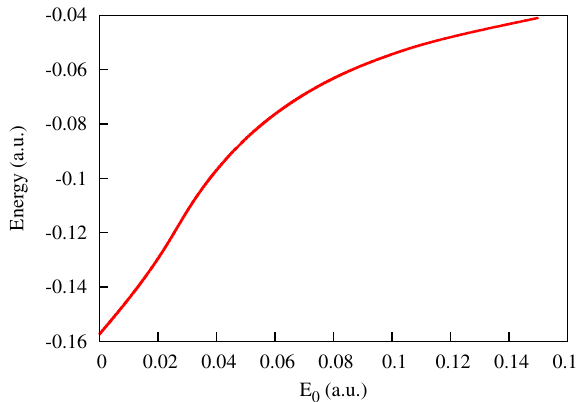
Figure 1. Ground state energy of the KH Hamiltonian (3) for different strengths E 0 of the IR driving